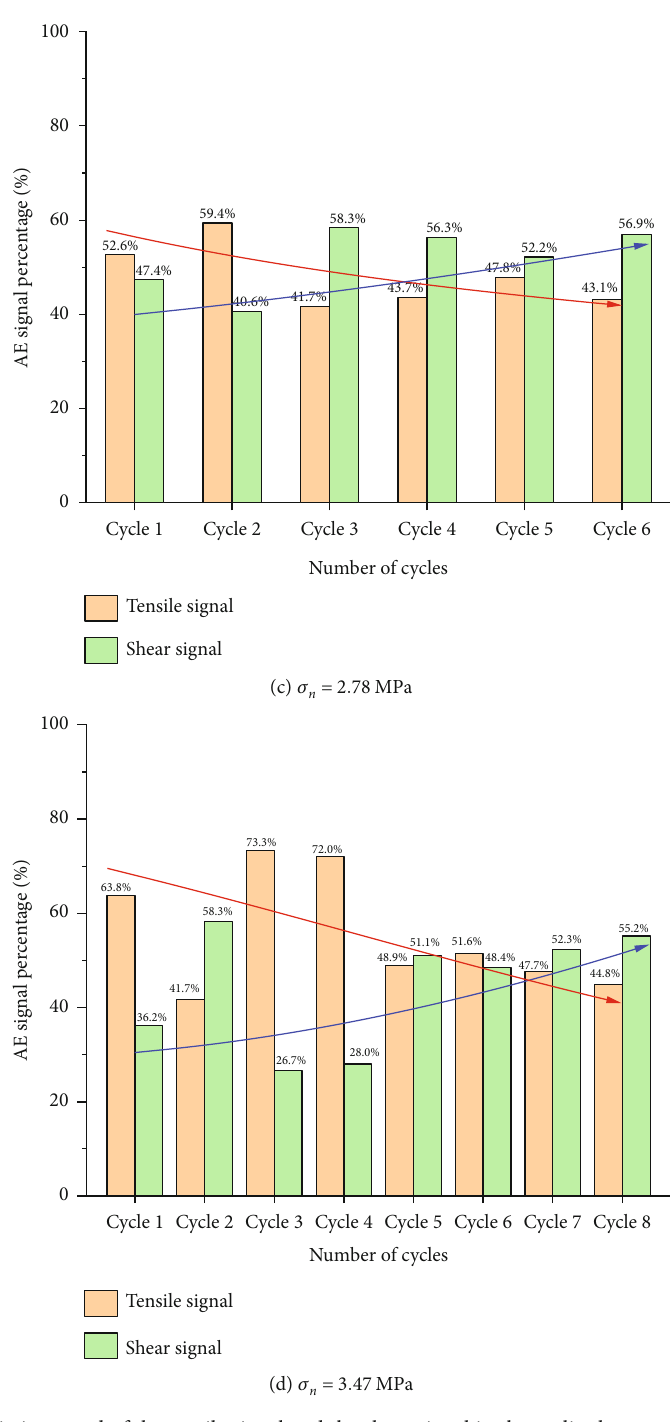
Figure 12: The proportion variation trend of the tensile signal and the shear signal in the cyclic shear process under four normal